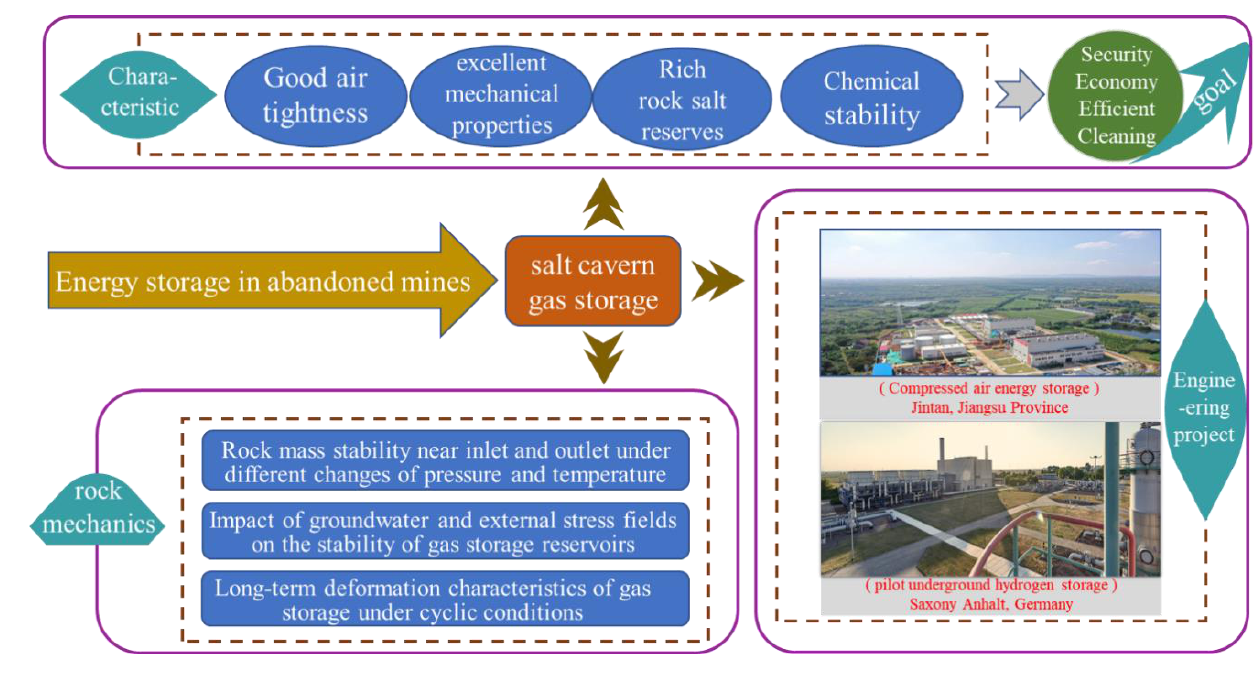
Figure 12. General framework of salt cave gas storage.